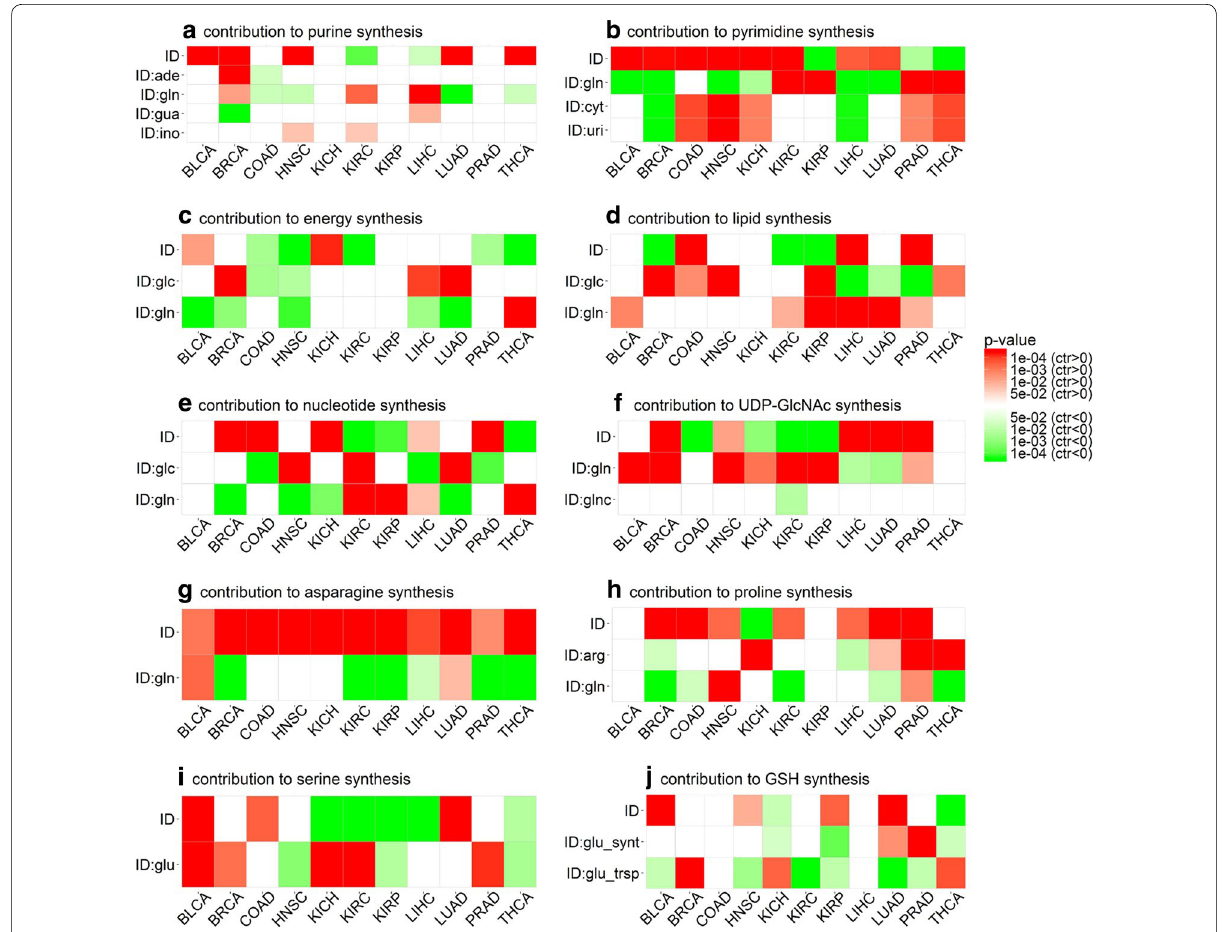
Fig. 5 The estimated level of statistical contribution: a to purine synthesis from glutamine (gln), adenosine (ade), guanosine (gua) and inosine (ino); b pyrimidine synthesis from glutamine, cytidine (cyt) and uridine (uri); c energy synthesis from glutamine and glucose (glc); d lipid synthe- sis from glutamine and glucose; e nucleotide synthesis from glutamine and glucose; f UDP-GlcNAc synthesis from glutamine and glucosamine (glnc); g asparagine synthesis from glutamine; h proline synthesis from glutamine and arginine (arg); i serine synthesis from glutamate (glu); j GSH synthesis from glutamate synthesis (glu_synt), and transport (glu_trsp). In each panel, ID is a variable for assessing whether the expression level of a response pathway in the linear model differs significantly in cancer and controls, whereas ID:X is the estimated contribution of factor X to the response pathway, where the color represents if a factor has increased (red) or decreased (green) contribution in cancer and controls. BLCA, bladder urothelial carcinoma; BRCA, breast invasive carcinoma; COAD, colon adenocarcinoma; HNSC, head and neck squamous cell carcinoma; KICH, kidney chromophobe; KIRC, kidney renal clear cell carcinoma; KIRP, kidney renal papillary cell carcinoma; LIHC, liver hepatocellular carcinoma; LUAD, lung adenocarcinoma; PRAD, prostate adenocarcinoma; THCA, thyroid